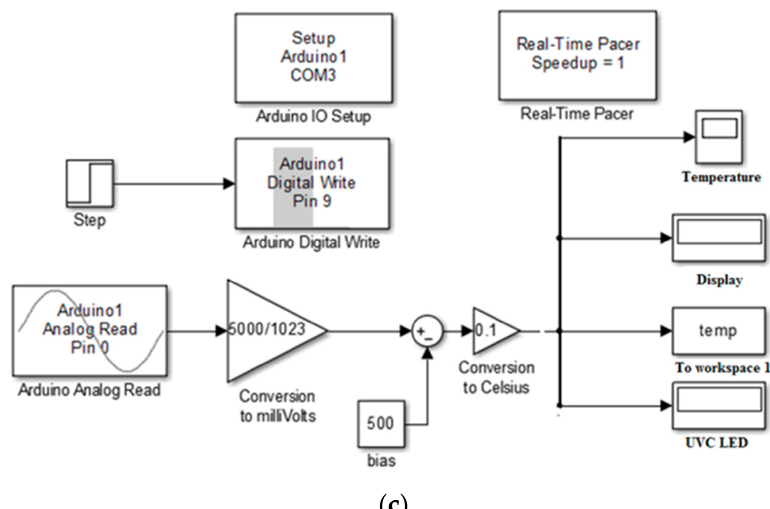
Figure 2. Arduino ‐ based UV ‐ C and conducting yarn ‐ based heater for Germicidal Face Mask: ( a ) simulation ‐ based circuit Figure 2. Arduino-based UV-C and conducting yarn-based heater for Germicidal Face Mask: ( a ) simulation-based circuit diagram using Tinkercad; ( b ) experimental ‐ based circuit diagram, ( c ) Simulink block diagram for controlling output sig ‐ diagram using Tinkercad; ( b ) experimental-based circuit diagram, ( c ) Simulink block diagram for controlling output signals nals for conducting yarn ‐ based heater and the FAR ‐ UV ‐ C LED . for conducting yarn-based heater and the FAR-UV-C